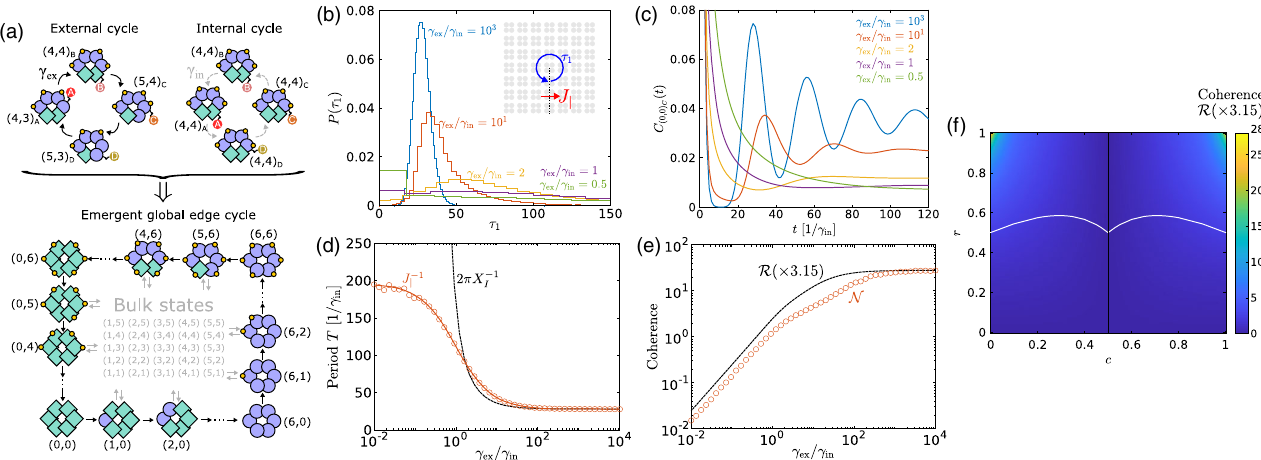
FIG. 6. (a) Four-state model (with N x ¼ N y ¼ 6 ) for a hexameric biomolecular oscillator such as the KaiABC system, involving allosteric conformational changes of the monomers (circles to squares) and phosphorylation (yellow added circles). The emerging topologically protected edge state of this model corresponds to cycles of conformational change, phosphorylation, conformational change, and dephosphorylation. (b) Probability distribution of times τ 1 to complete one cycle obtained from stochastic simulations, defined as two subsequent crossings of the dashed line shown in the inset (the flux through which is denoted as J γ = γ . (c) Correlation function representing the probability of finding the system in state ð 0 ; 0 Þ ex in = γ , showing damped oscillations. (d) Period T of the oscillations as a function of γ time zero, for the same values of γ ex in from (circles) the mean cycle time in stochastic simulations, (red solid line), the inverse of the analytically calculated steady-state flux J and (dashed black line) the inverse of the imaginary part X I of the slowest-decaying eigenmode of the transition matrix W . (e) Two measures, N (obtained from stochastic simulations) and R (obtained from the slowest-decaying eigenmode of W ), for the coherence of = γ the oscillations as a function of γ (see the main text for their definition). (f) Coherence R in the full parameter space spanned by r ex in and c , showing that coherence is maximized in the fully chiral limit ( c → 0 or 1) and deep in the topological phase ( r → 1 ). The white curve represents the boundary r (cid:4) ð c Þ separating the topological and trivial phases of the system. For each curve in panel (b) and each data point in panels (d) and (e), we used 10 7 stochastic simulation steps starting from a random initial